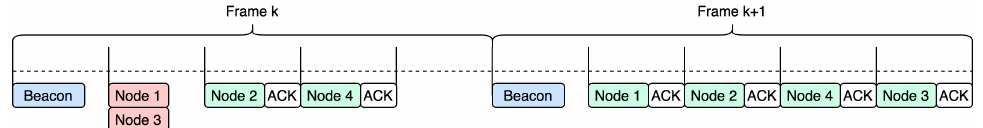
Figure 6. Sequence diagram for R-Aloha reservation protocol.